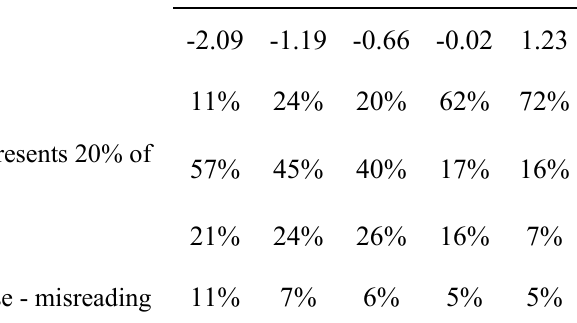
Table 2 : Inferred mathematical procedure for responses by quintile group Mean locations of 5 quintile